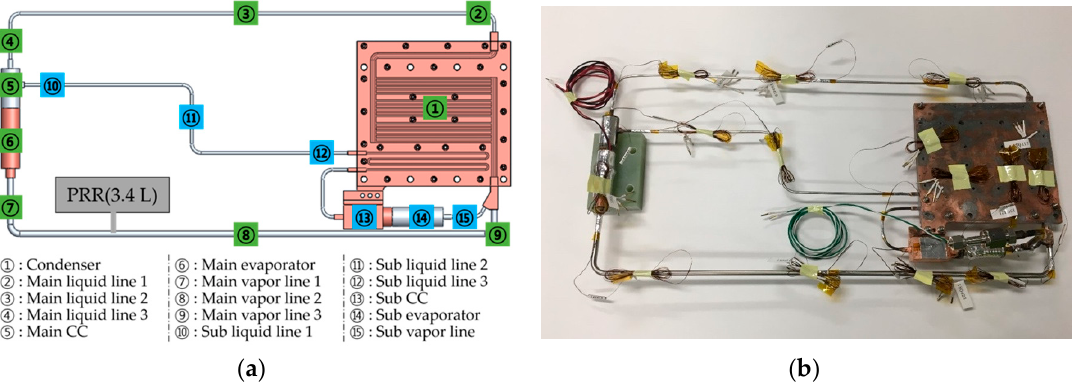
Figure 5. Temperature measurement location of the CLHP: ( a ) Location of the temperature sensor; ( b ) Installation of the temperature sensor.